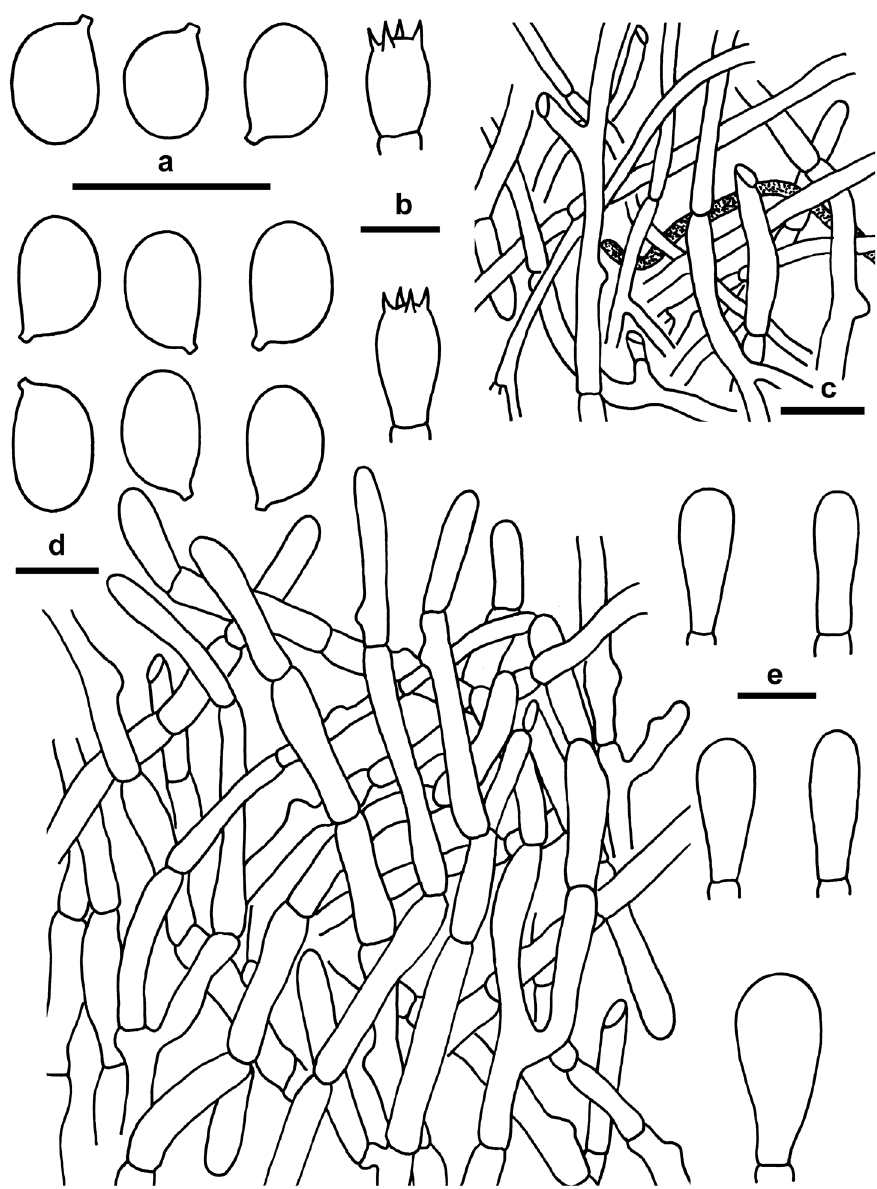
Figure 7. Microscopic features of Heinemannomyces splendidissimus (GDGM 46633). a Basidiospores b Basidia c Elements from stipe surface d Pileipellis e Cheilocystidia. Scale bars: 10